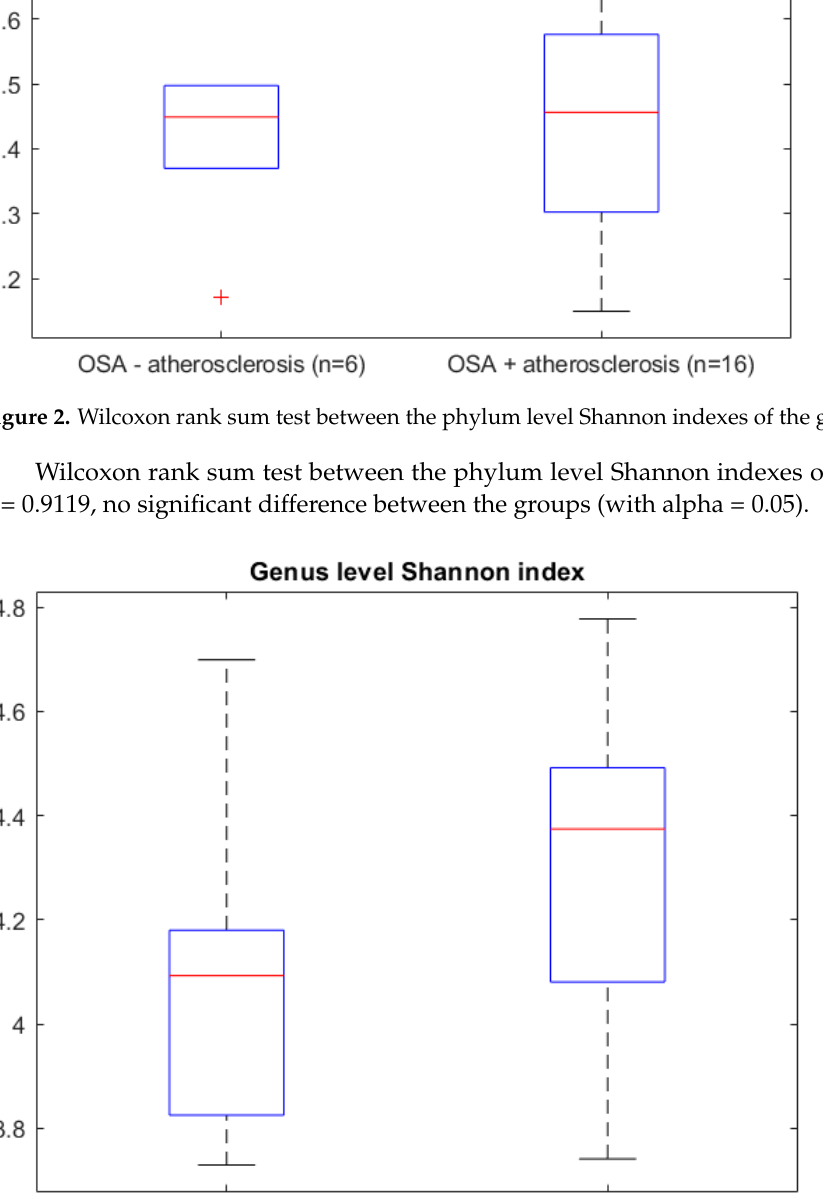
Figure 4. Beta diversity analyses at the phylum level: PCoA based on Bray–Curtis distance measure. Green: OSA − atherosclerosis. Red: OSA + atherosclerosis.